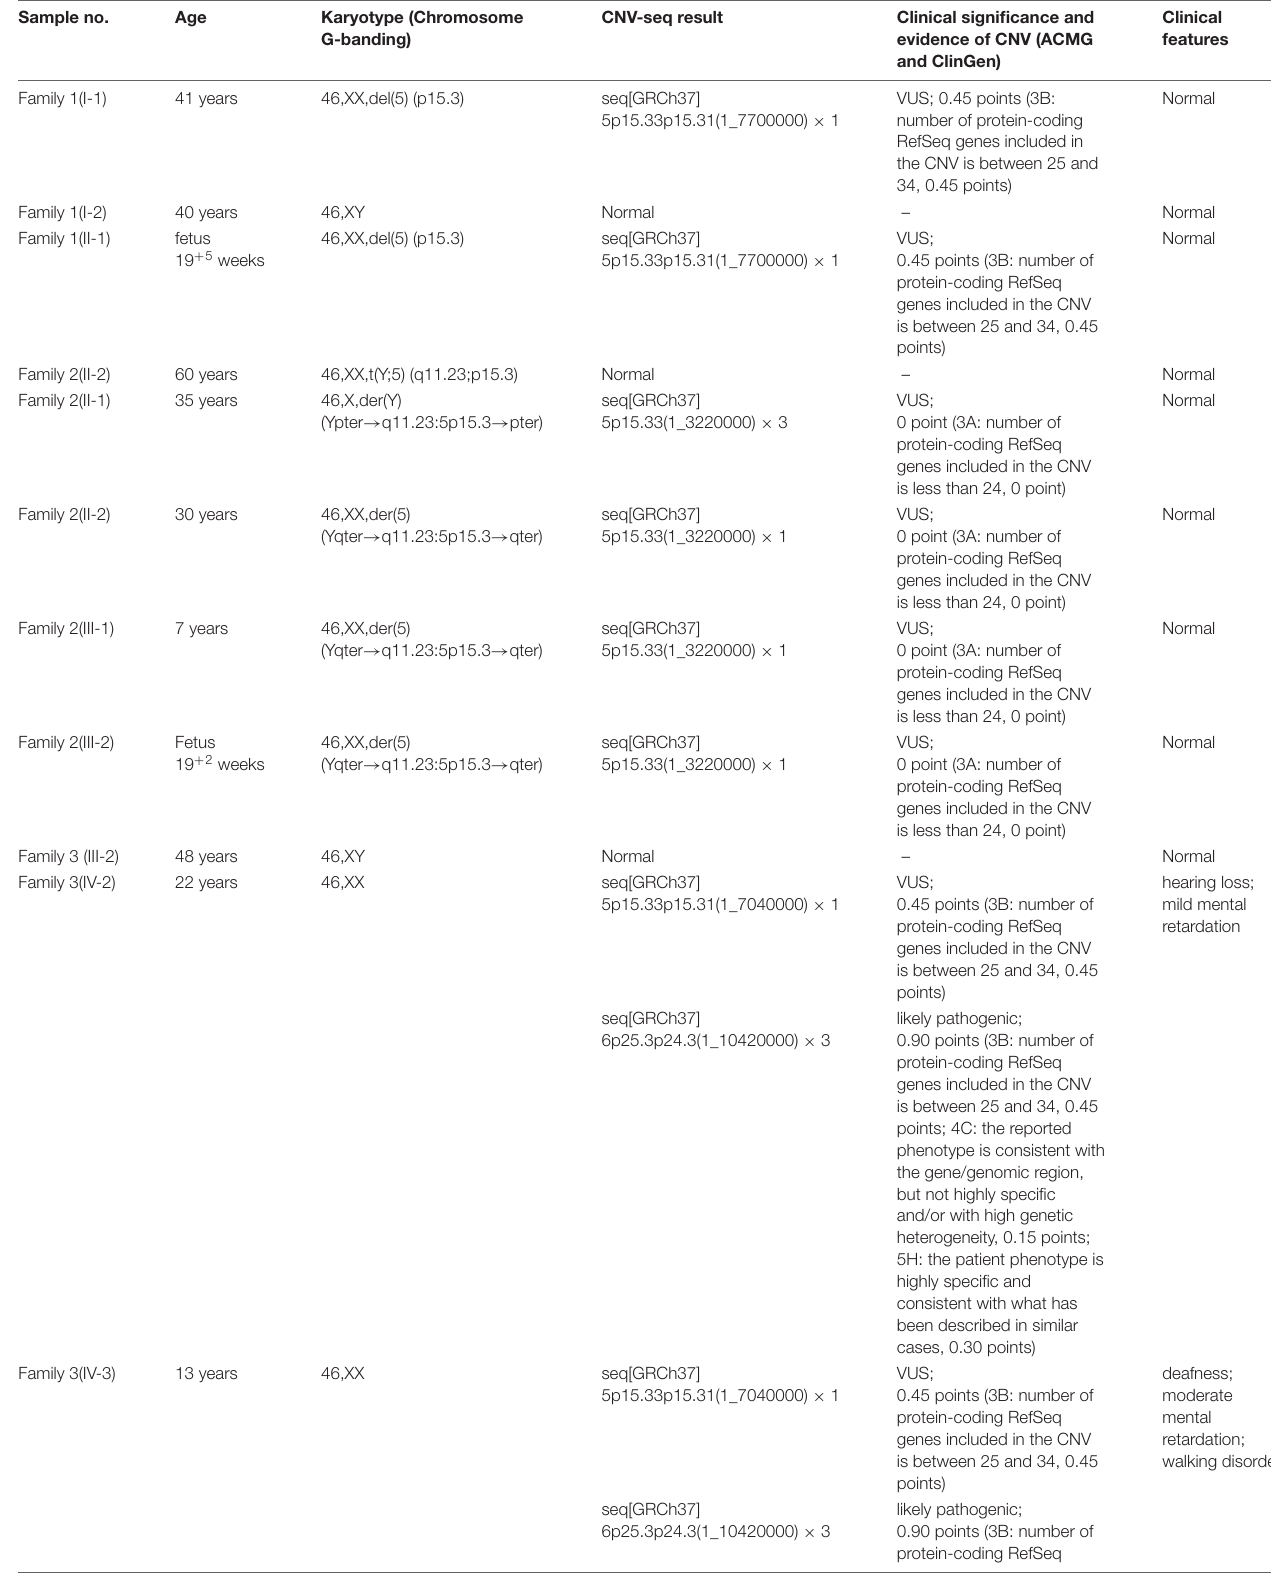
TABLE 1 | Summary of samples included in our study. Sample